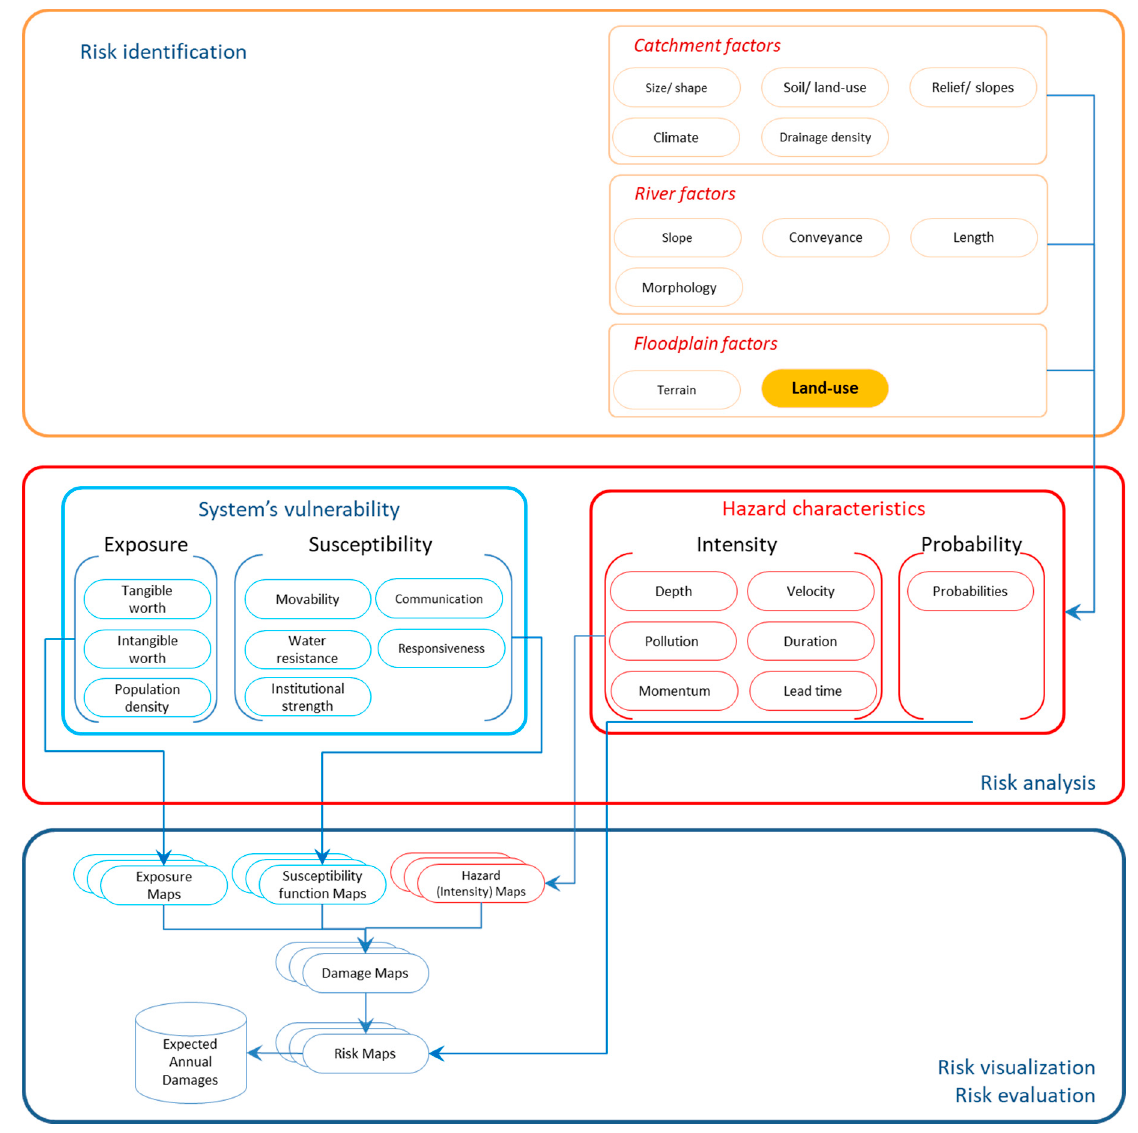
Figure 5. A guiding flowchart expressing the conceptual approach to determine the hazard, vulnerability, and risk as- sessment.